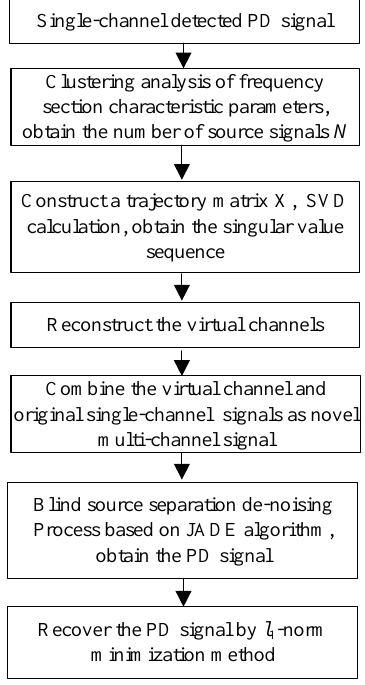
Figure 2. Flow chart of single-channel blind source separation de-noising algorithm.